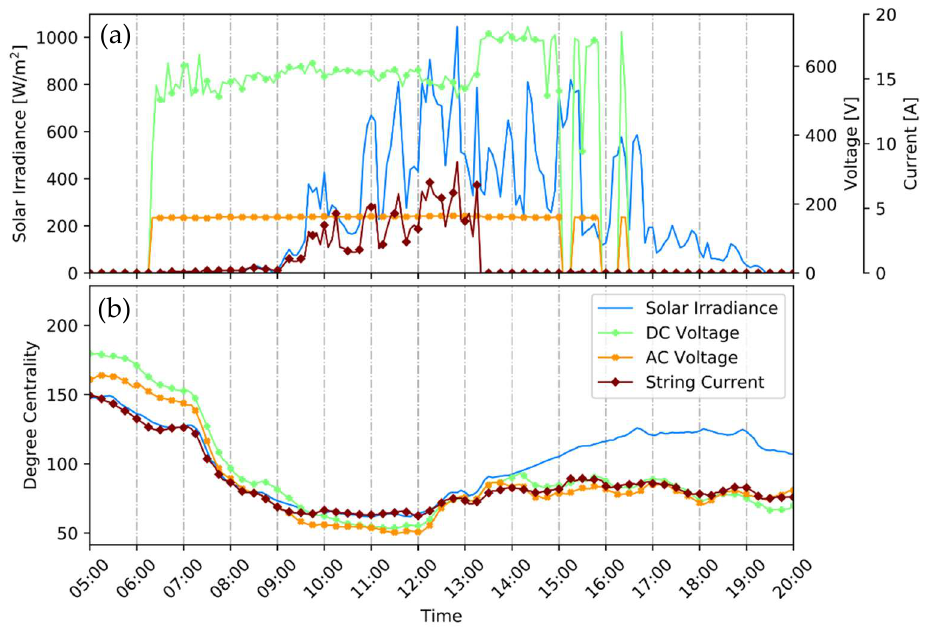
Figure 5. Analysis of ( a ) sensor signals from block A of the inverter 1 compared with ( b ) sensor network CNA metrics on 31st August.